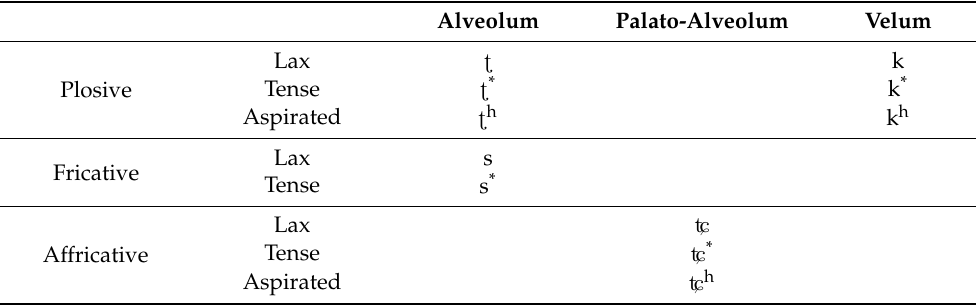
Table 1. Classification of Korean consonants based on the tongue position and the intensity of production.